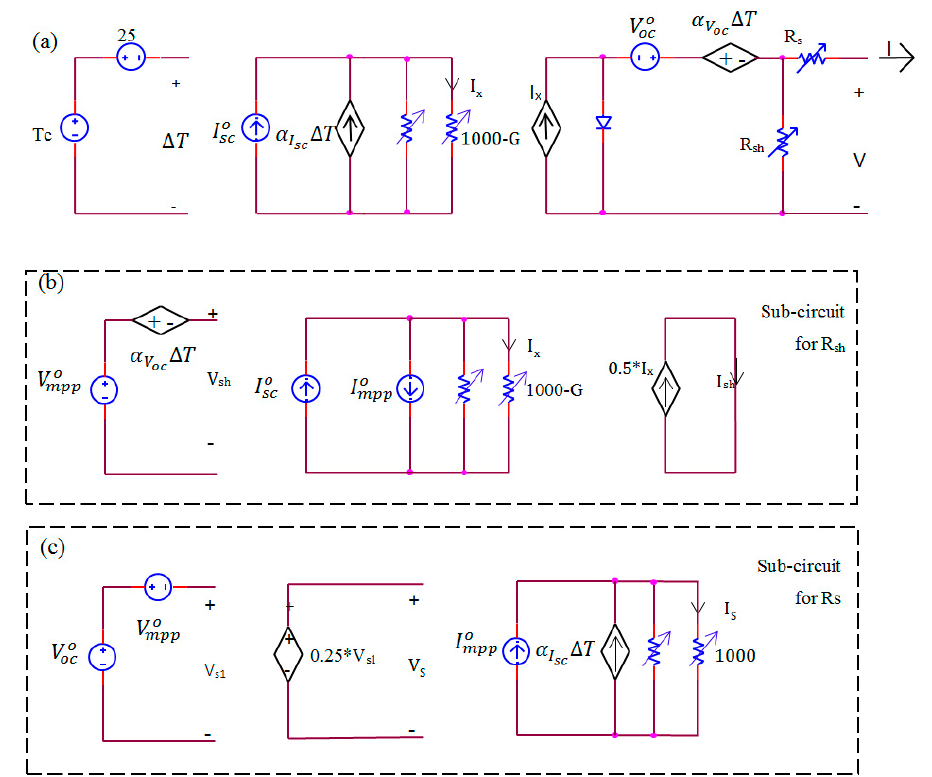
Figure 4. Electrical circuit of a photo-voltaic (PV) cell, depending on the environmental conditions. ( a ) Main circuit; ( b ) Sub-circuiti for R sh ; ( c ) Sub-circuiti for R s . Resistor R sh and sub-circuit ( b ) are neglected for the simplified model.